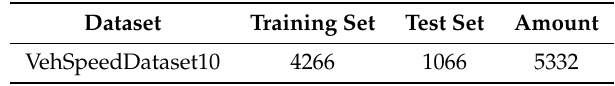
Table 2. Illustration of the Vehicle Speed Dataset named